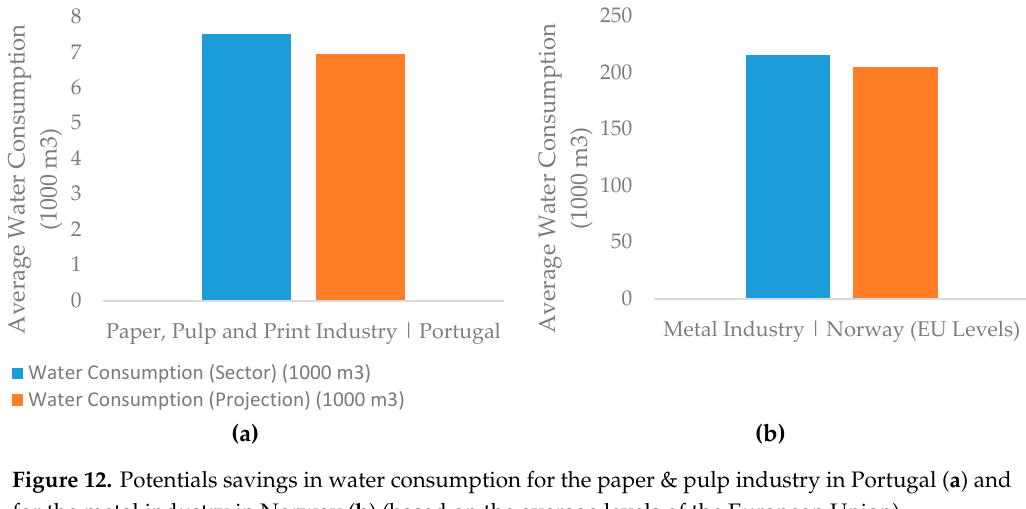
Figure 11. Potentials savings in water consumption for each approached industrial sector in Germany.